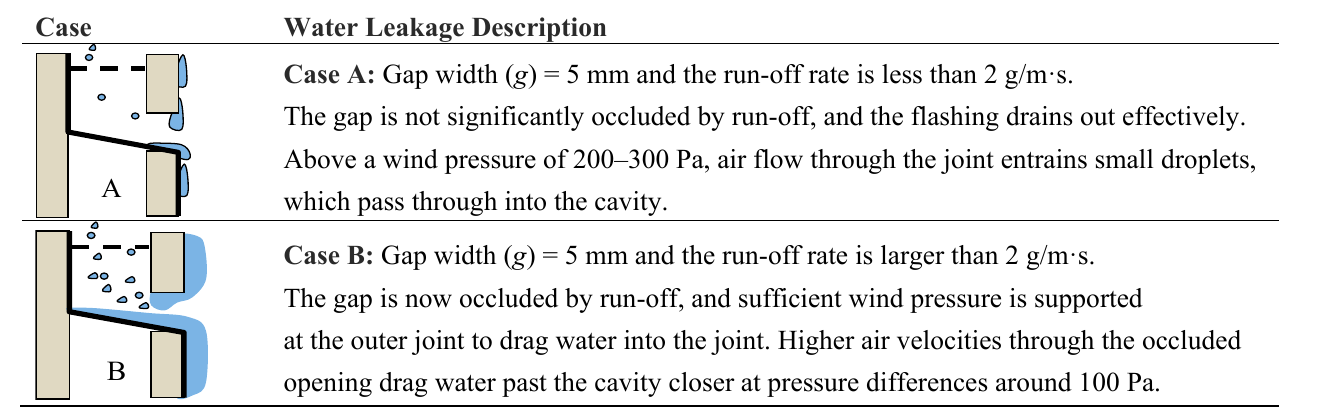
Table 1. A pictorial view of leakage through a window head joint with varying surface run-off rates and gap dimension ( g ) between upper cladding and head